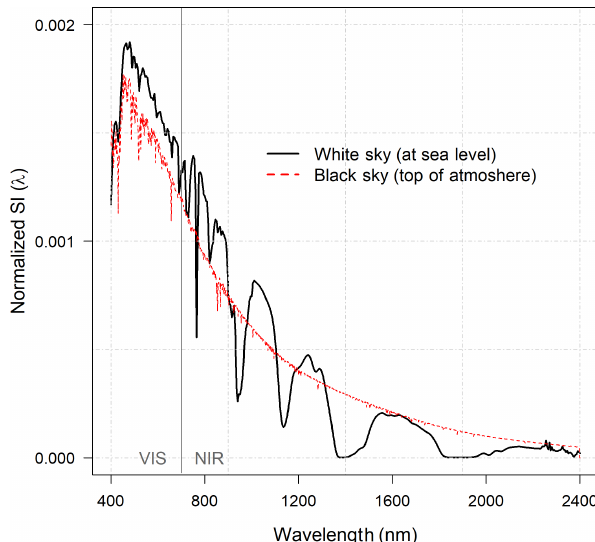
Figure 1. The normalized (i.e., summed to unity between 400 and 2400nm) white-sky solar irradiance spectra (SI (λ) ) measured at sea level and, for reference, the normalized black-sky top-of-the- atmosphere spectra by Thuillier et al. (2003). The figure is shown to illustrate the effect of atmosphere on the shape of SI (λ) (note that in our calculation the white-sky spectra were renormalized within VIS (400–700nm) and NIR (701–2400nm)